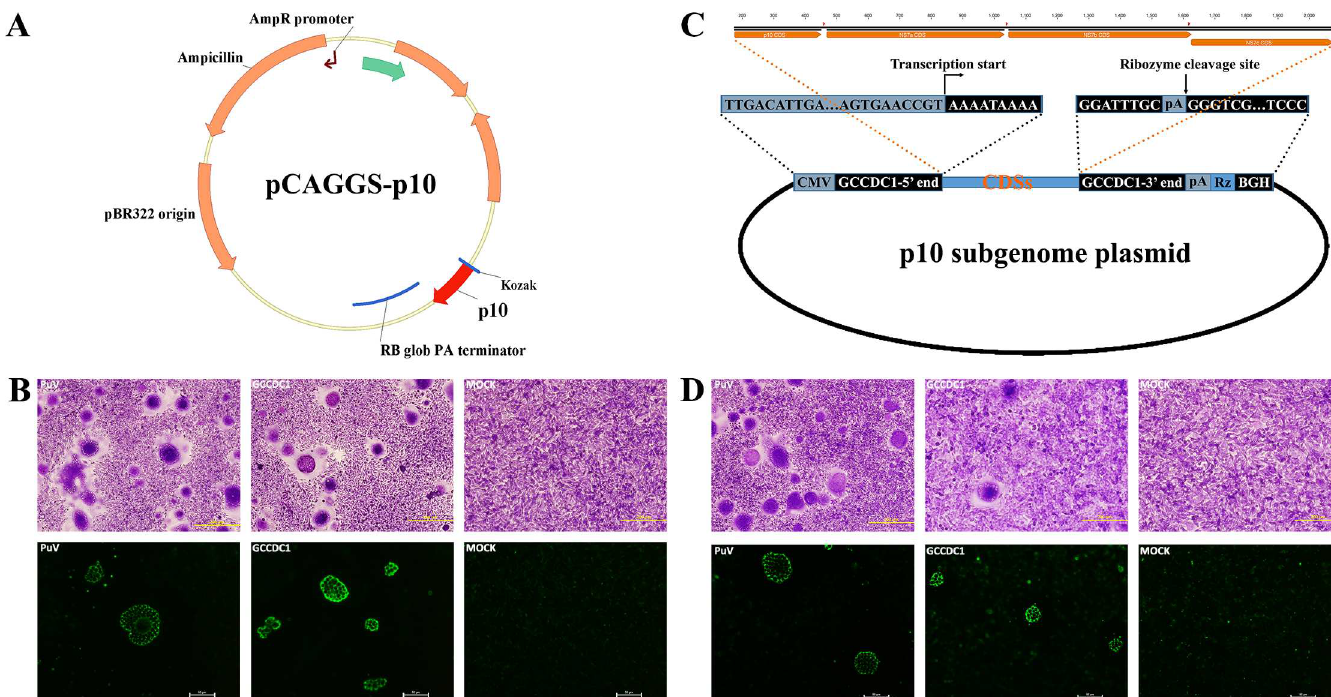
Fig 8. Syncytiumformationand functional analyses of Ro-BatCoVGCCDC1 p10 gene. (A) The construction of transient expression plasmidof p10 gene based on a pCAGGS vector. (B) Transient expression of the p10 gene and syncytium formation. Top: the observation of syncytium formationwith Wright-Giemsa stainingon the monolayer BHK-21 cells transfected with recombinant plasmidof Pulau virusp10 gene, recombinant plasmidof Ro-BatCoV GCCDC1 p10 gene, and empty pCAGGS vector; Bottom: the observation of syncytium formationwith indirectimmunofluorescence stainingon the cells treatedas described above. (C) The construction of subgenomic plasmidof p10 gene. The putative subgenome of p10 was clonedinto a pcDNA3.0-derivedvector. (D) Transient expression of the p10 gene and syncytiumformationwith recombinant subgenomic p10 plasmid. Top: the observation of syncytiumformationwith Wright-Giemsa stainingon the monolayer BHK-21cells transfected with recombinant plasmidof Pulau virusp10 gene, recombinantplasmidof p10 subgenome of Ro-BatCoV GCCDC1and emptypcDNA3.0vector; Bottom: the observation of